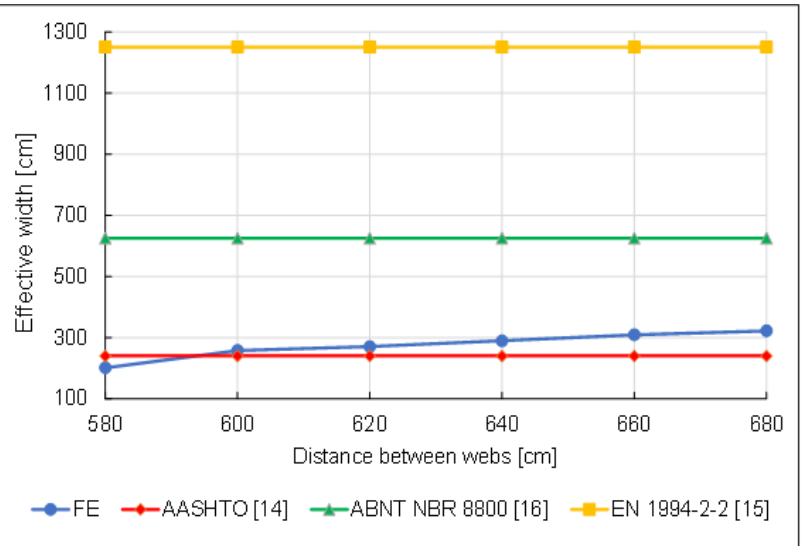
Figure 15. Effective width versus distance between webs for simple box